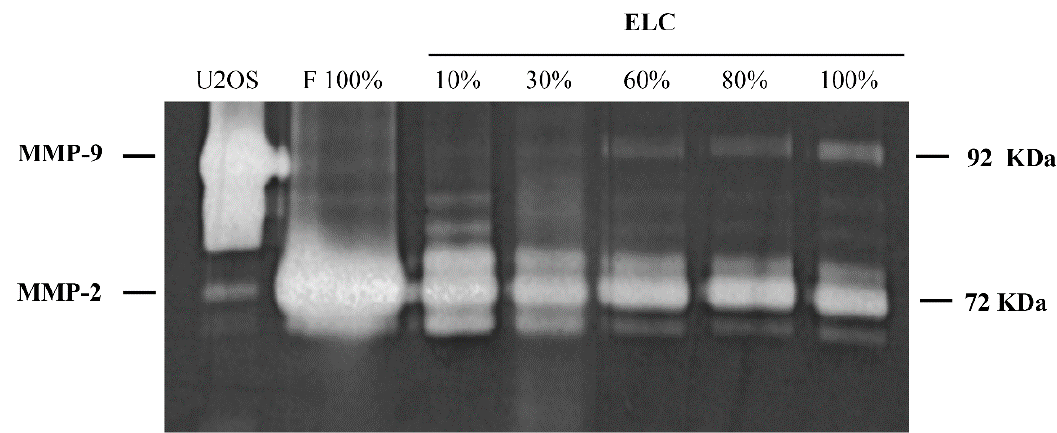
Figure 6. A gradual increase in the MMP-9 activity with a concomitant decrease in the MMP-2 activity is observed as more fibroblasts undergo MET in culture. Basal analysis of gelatinase activities analyzed by zymography in whole culture media from fibroblasts cultures containing different percentages of ELC (10–100%). Culture media from U2OS cells (epithelial cell line) was used as a control. F: fibroblasts; ELC: epithelial-like